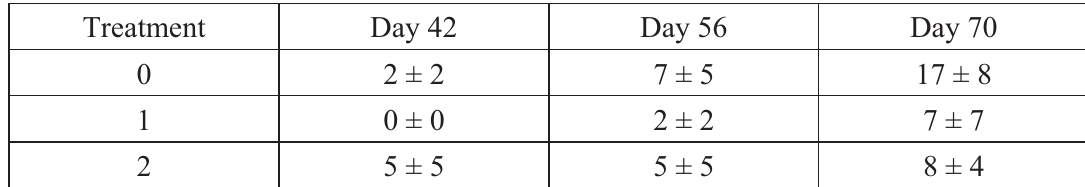
Table 2. Eastern Equine Encephalomyelitis (EEE) titers of weanlings before and after vaccination by treatment group and day after arrival. There were equal numbers (n = 2 each) of North Dakota and Canadian horses in each group. Vaccines were administered on day 46 and boosters were given on day 56. Vaccines were not given on day 70. Treatment 0 received only the carrier (unsupplemented applesauce), Treatment 1 supplementation of 5 g ascorbic acid twice a day was stopped on day 5 post arrival and Treatment 2 of 5 g ascorbic acid twice a day was discontinued on day 10 after arrival. Values are means ± SE. There were no differences ( P > 0.2) either among treatments or over time within treatment groups.